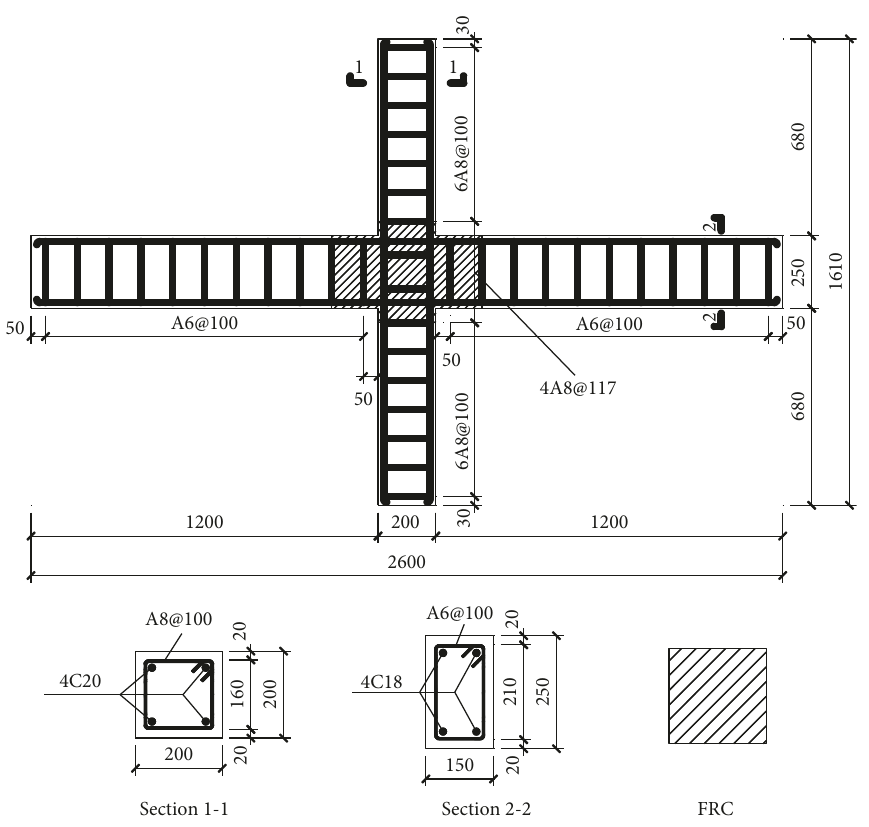
Figure 26: Dimension of the HFRC beam-column joint specimens.